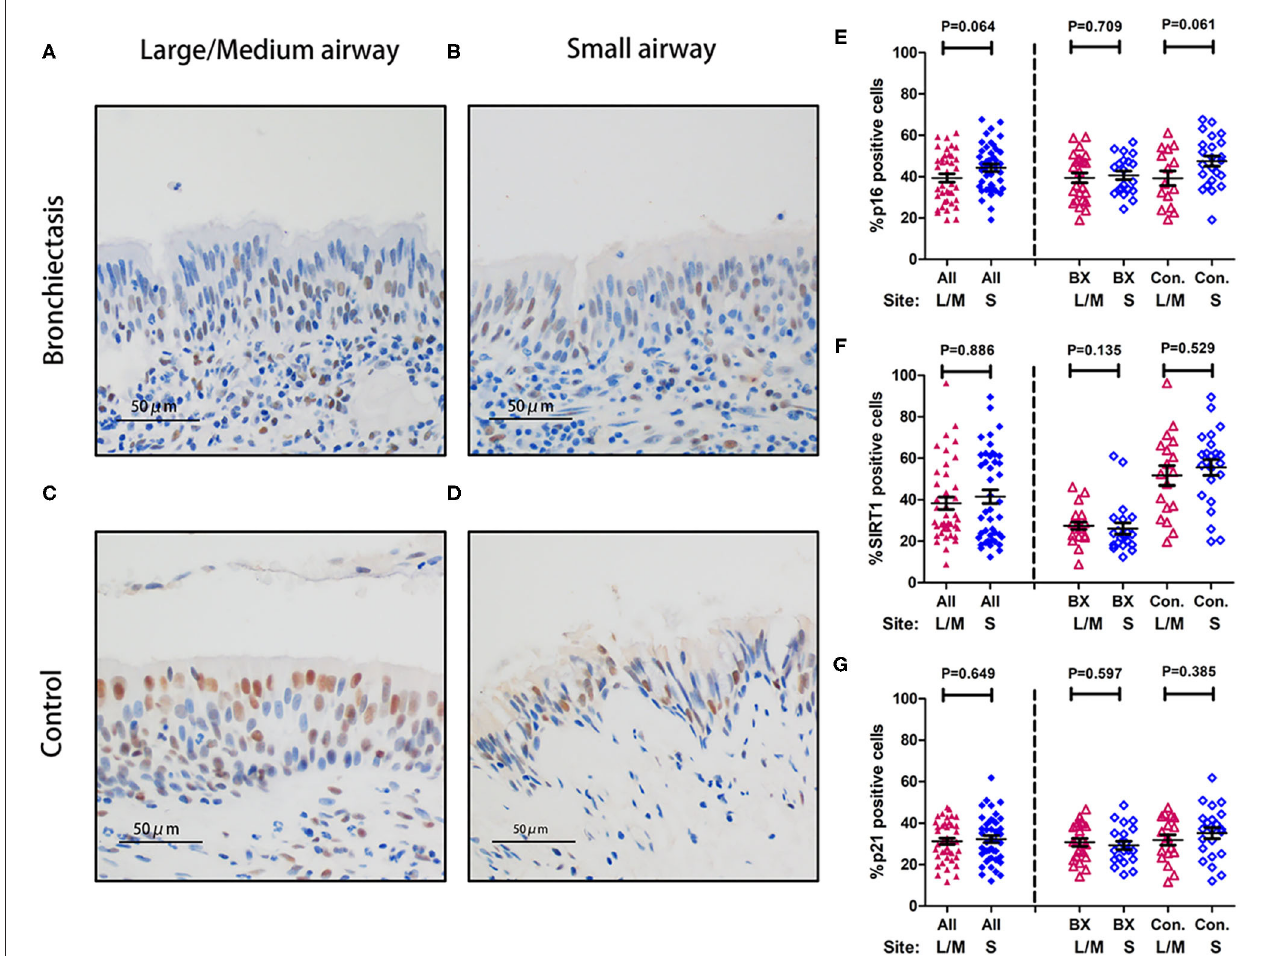
FIGURE 6 | Expression of p16, SIRT1, and p21 between large-to-medium and small airways within the same study participant. (A–D) Representative images showing the expression patterns of p16, SIRT1, and p21 within the bronchial epithelium in patients with bronchiectasis and disease controls scheduled for segmentectomy or lobectomy. (A) Immunohistochemistry staining within the large-to-medium airway in a patient with bronchiectasis (a 31-year-old female); (B) Immunohistochemistry staining within the small airway in a patient with bronchiectasis (a 31-year-old female); (C) Immunohistochemistry staining within the large-to-medium airway in a disease control (a 59-year-old male); and (D) Immunohistochemistry staining within the small airway in a disease control (a 59-year-old male). Positive staining is defined as the presence of staining of the senescence marker within the cell nuclei. (E–G) Dot plots demonstrating the percentage of positively stained cells corresponding to the three senescence markers and different anatomical sites. (E) The percentage of positively stained cells for p16; (F) The percentage of positively stained cells for SIRT1; and (G) The percentage of positively stained cells for p21. All, all study participants; BX, bronchiectasis; Con, disease control; L, large-to-medium airways; S, small airways; SIRT1, sirtuin